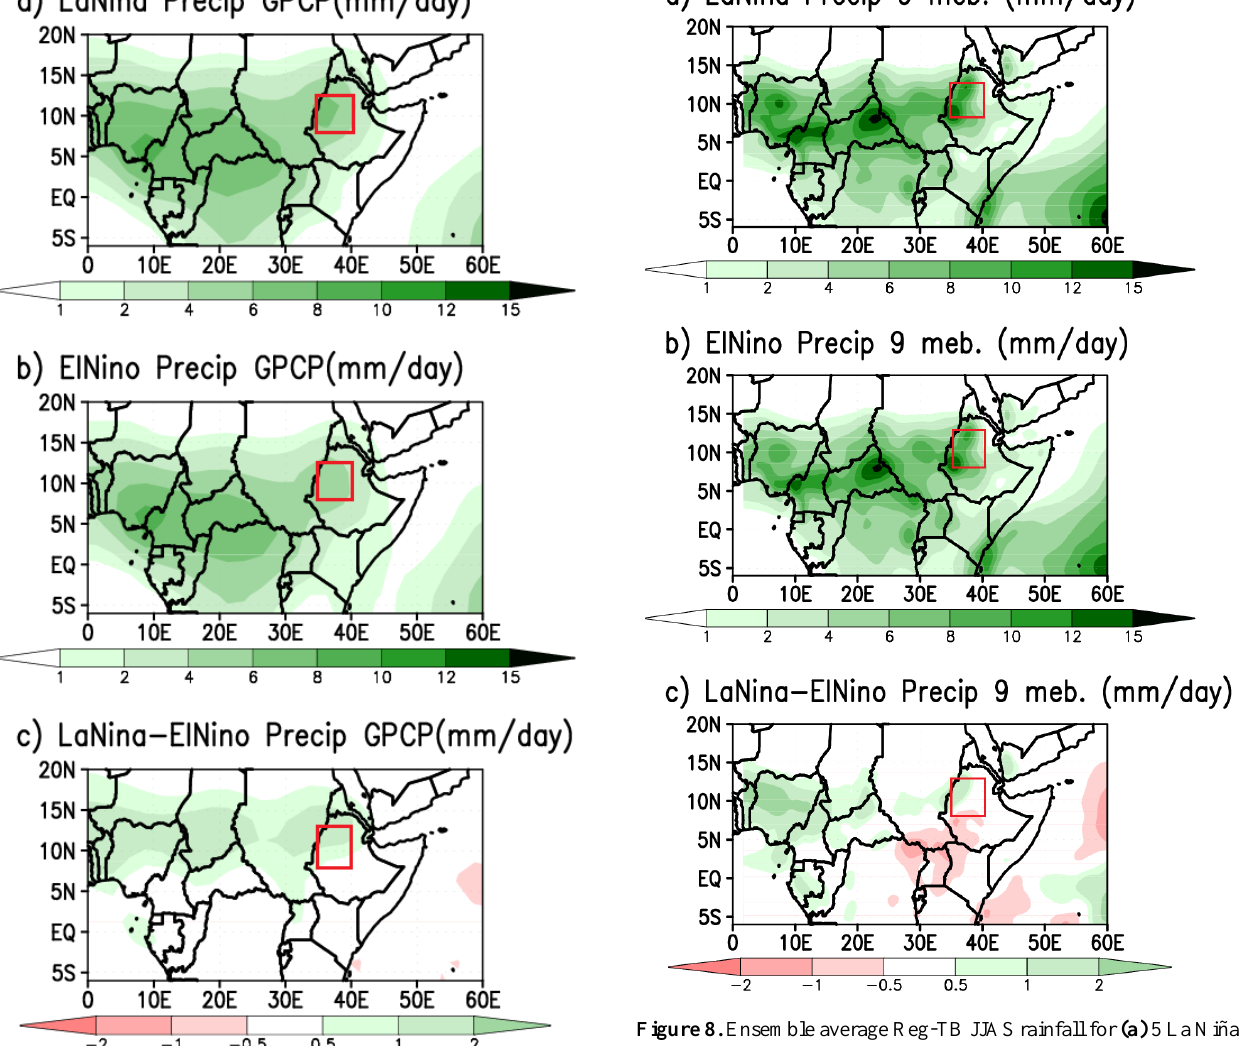
Figure 8. Ensemble average Reg-TB JJAS rainfall for (a) 5 La Niña years (1988, 1998, 1999, 2007 and 2008), (b) 5 El Niño years (1982, 1983, 1987, 1992 and 2002), and (c) the difference between La Niña years and El Niño